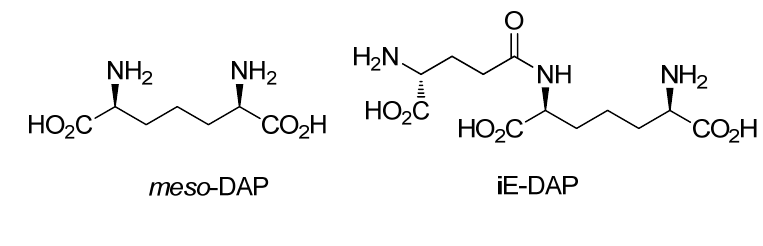
Figure 1. Structures of meso -DAP and